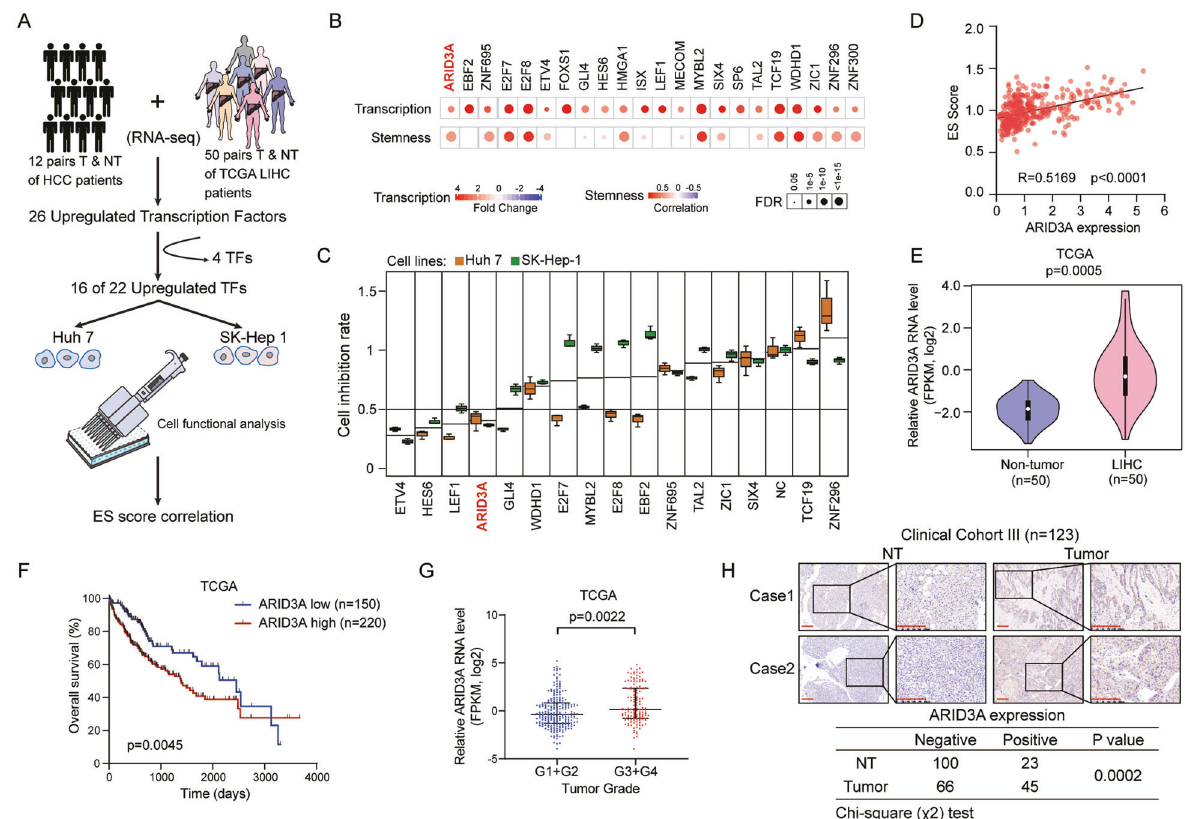
Fig. 1 High expression of ARID3A correlates with poor outcomes and cancer stemness in liver cancer patients. A Schematic diagram of the protocol used to search for candidate oncogenic TFs in liver cancer. B Upregulation patterns and correlation levels with ES scores of 22 selected TFs in patients in the TCGA-LIHC cohort. The colour intensity indicates the fold change or correlation coef fi cient, and the point size indicates the statistical signi fi cance at a given FDR. Two-tailed Student ’ s t- test or Spearman ’ s rank correlation analysis and followed by FDR adjustment for p -value. C The cell growth inhibition rate after transfection of siRNA into Huh7 and SK-Hep-1 cells was determined on Day 5 using a CCK-8 assay. The values are expressed as the means ± SEMs, n = 3. biologically independent experiments. D The correlation between the ES scores of individual patient samples and ARID3A expression was determined in the TCGA-LIHC dataset. n = 374, Spearman ’ s rank correlation analysis. E ARID3A expression was increased in tumour tissues in 50 paired samples in the TCGA-LIHC cohort, two-tailed Student ’ s t -test. F Kaplan – Meier analysis of overall survival for liver cancer patients in the TCGA-LIHC cohort ( n = 370), Log-rank test. G The expression of ARID3A in LIHC patients with different tumour grades in the TCGA cohort. n = 232 for G1 + 2 and n = 134 for G3 + 4, two-tailed Student ’ s t -test. The values are expressed as the medians with interquartile ranges. H IHC analysis of ARID3A in tumour and adjacent nontumour (NT) tissues (scale bar, 200 μ m). n = 111 tumour tissues and n = 123 NT tissues, chi-square (Co-IP) and liquid chromatography-mass spectrometry (LC-MS) analysis revealed CEP131 as a binding partner of ARID3A. ARID3A can cooperate with CEP131 to transcriptionally activate KDM3A and promote expression of ES signature genes, suggesting that ARID3A and CEP131 are potential targets for the development of new anticancer therapeutics for liver cancer. RESULTS High expression of ARID3A correlates with ES cell-like gene We fi rst performed integrated analysis of the transcriptomic data from 50 paired HCC tumour and adjacent nontumour (NT) liver tissues in the TCGA-LIHC (The Cancer Genome Atlas-HCC) dataset and our twelve paired Chinese liver cancer samples (GSE101432) (Fig. 1A). By taking the intersection of the two cohorts, we identi fi ed 26 upregulated TFs with twofold upregulation in tumour tissues compared with NT liver tissues, although four of them (E2F1, FOXM1, LIN28B, and MYCN) were excluded for over- representation. Next, the remaining 22 TFs were used to establish ES cell-like gene expression signature scores (ES scores) based on